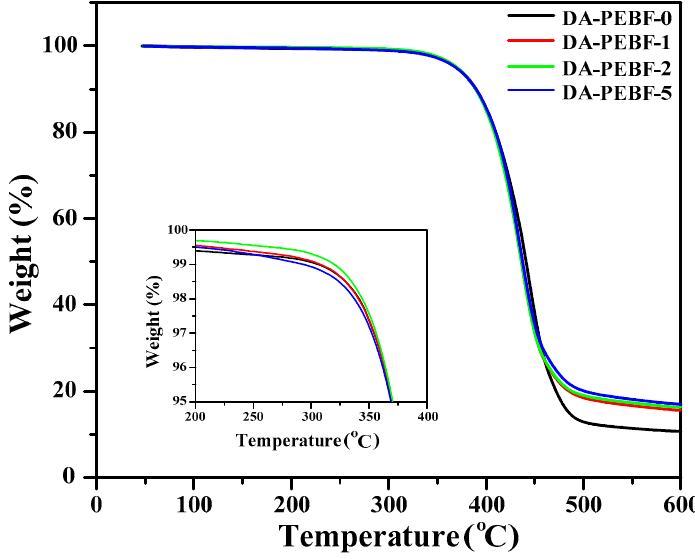
Table 2. Thermal properties of PEBF/graphene/BMI hybrids with different loading of graphene.